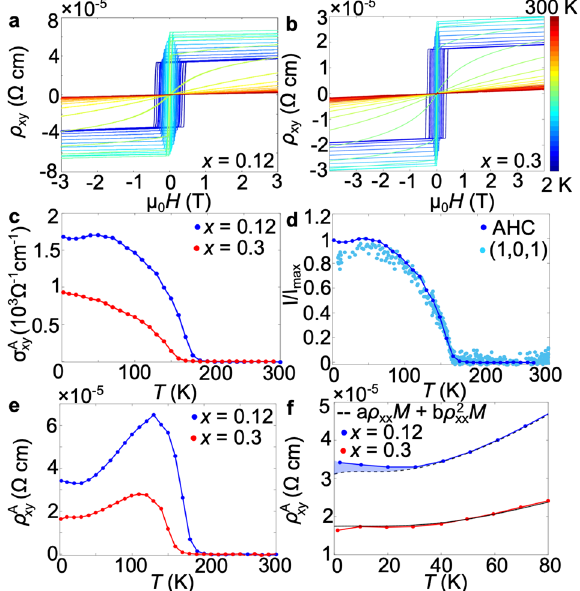
Fig. 3 Transport measurements of Co 3 Sn 2- x In x S 2 . Field depen- dence of ρ xy for ( a ) x = 0.12 and ( b ) x = 0.3. c Temperature dependence of the anomalous Hall conductivity. d Anomalous Hall conductivity compared to order parameter of (1,0,1) magnetic peak. e Temperature dependence of the anomalous Hall resistivity. f Anomalous Hall resistivity compared fi t to the expected contribu- tions from intrinsic and extrinsic scattering mechanisms. Deviations at low temperature in the x = 0.12 sample (shaded in blue) indicate a possible topological Hall contribution due to non-zero spin